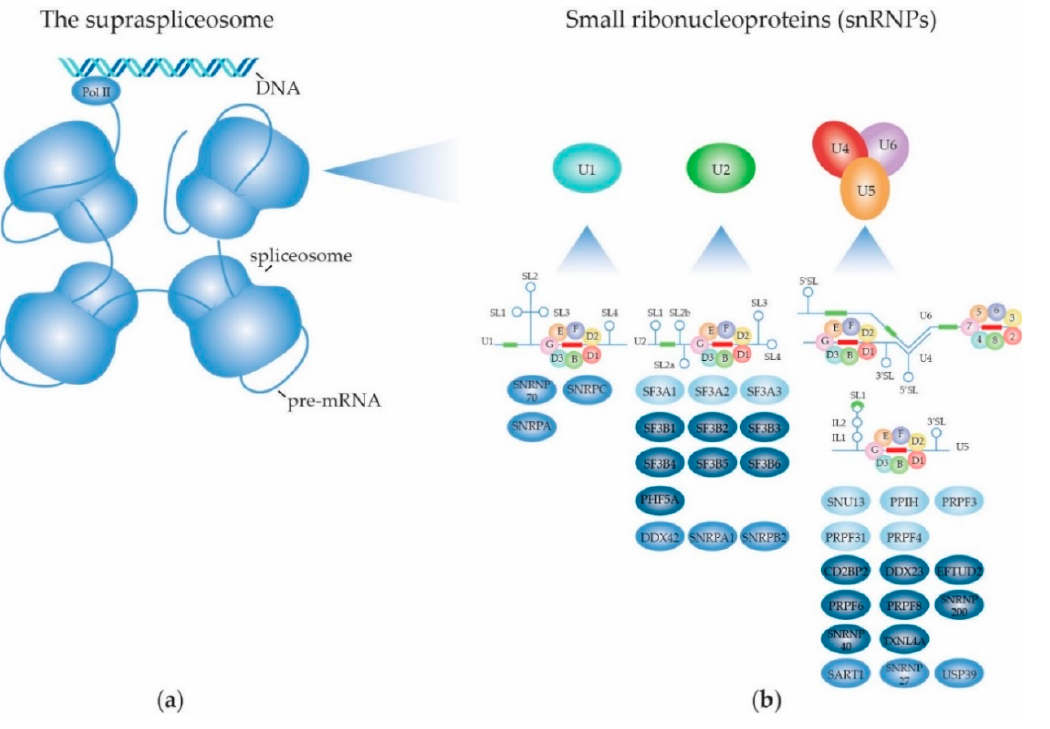
Figure 1. Structure and composition of the supraspliceosome. ( a ) Schematic impression of the macromolecular structure of the supraspliceosome, consisting of four native spliceosomes assembled onto a pre-mRNA being transcribed by RNA Pol II. In addition to pre-mRNA splicing carried out by the spliceosomes, the supraspliceosome provides a platform for all other co-transcriptional mRNA processing activities (by proteins that are not shown in the illustration). ( b ) Major components of the spliceosome U1, U2, and U4/U6.U5 snRNP subunits, with their Sm-snRNA core complexes and subunit-specific splicing factor proteins (U2: SF3a complex in light blue, SF3b complex in dark blue; U4/U6.U5: U4/U6-specific proteins in light blue, U5-specific proteins in dark blue). SL, snRNA stem-loop; red box, snRNA Sm site; green box, other RNA-binding domains (U1: 5 (cid:48) ss recognition sequence, U2: BPS recognition sequence, U6: U2/U6 duplex-forming